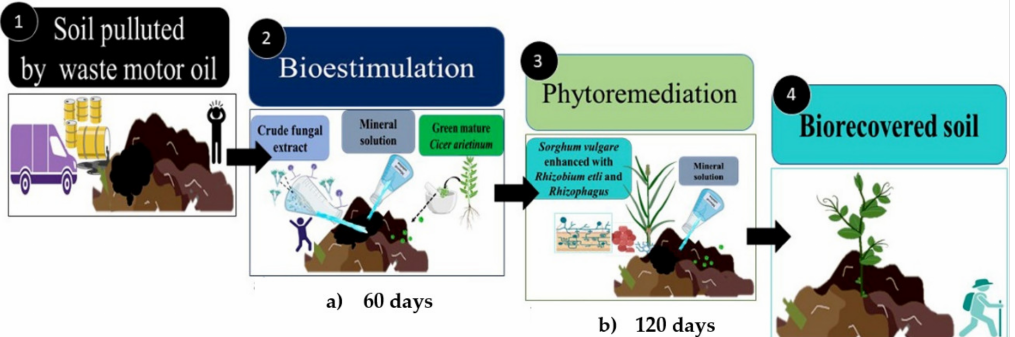
Figure 11. Scheme of the Biorecovering of an agricultural soil impacted by waste motor oil, biostimu- lated applied a crude fungal extract and Cicer arietinum as green manure followed for phytoremedia- tion using Sorghum vulgare inoculated with Rhizobium etli and Rhizophagus irregularis